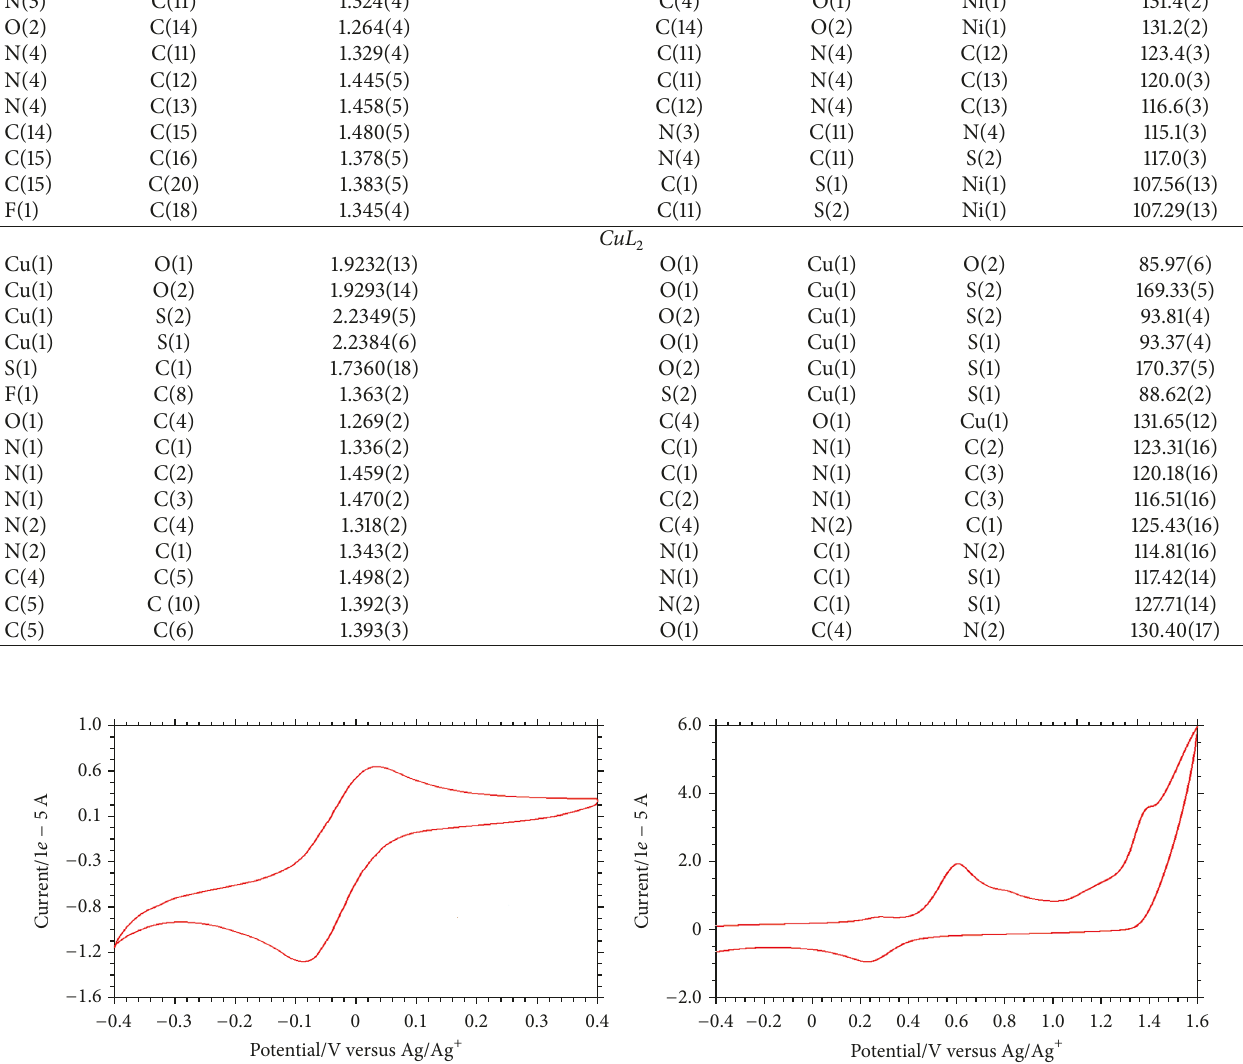
Cu(II)/Cu(I) couple. A similar study reported that thiourea Cu complexes showed the reduction of Cu(II)/Cu(I) redox system undergoing an irreversible process with peak separa- tion ( Δ E 𝑝 ) of about 0.200 V [21]. Duan et al. indicated that some modified thiourea derivatives undergo one-electron quasi-reversible and reversible redox reactions [41].